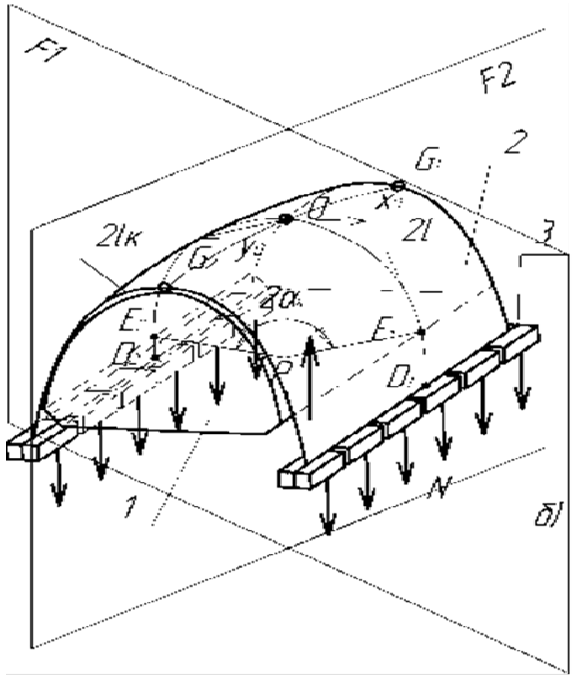
Figure 1. Scheme of the process of simple hanging over a tight punch of a shell of significant double curvature of a biconvex shape: 1 - punch; 2 - blank; 3 - press